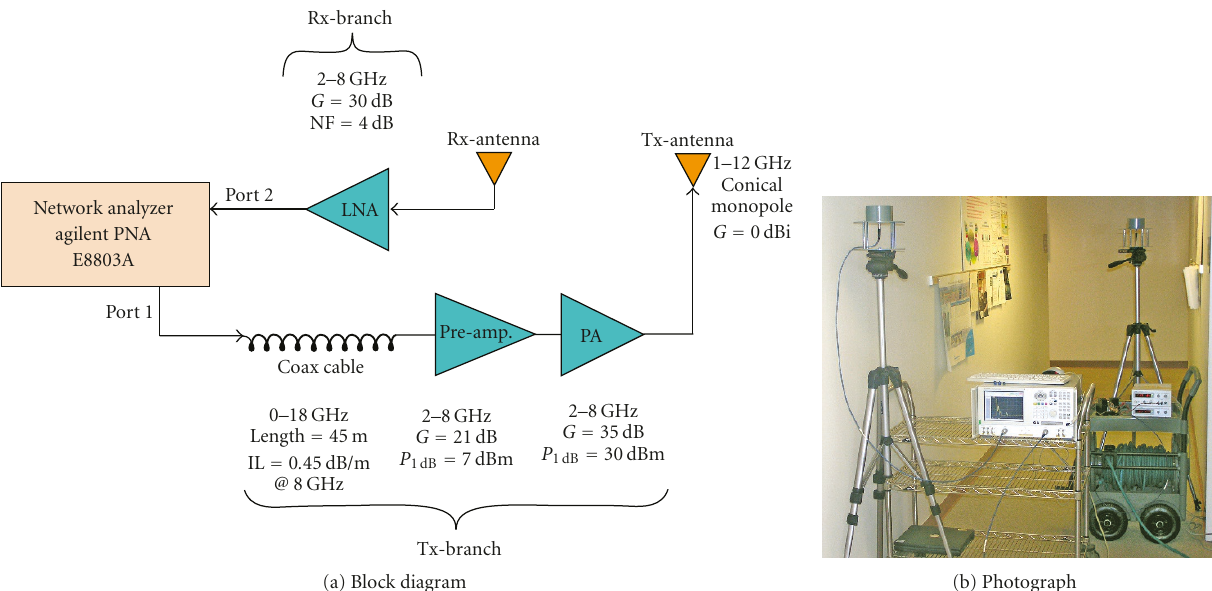
Figure 3: The measurement system using the vector network